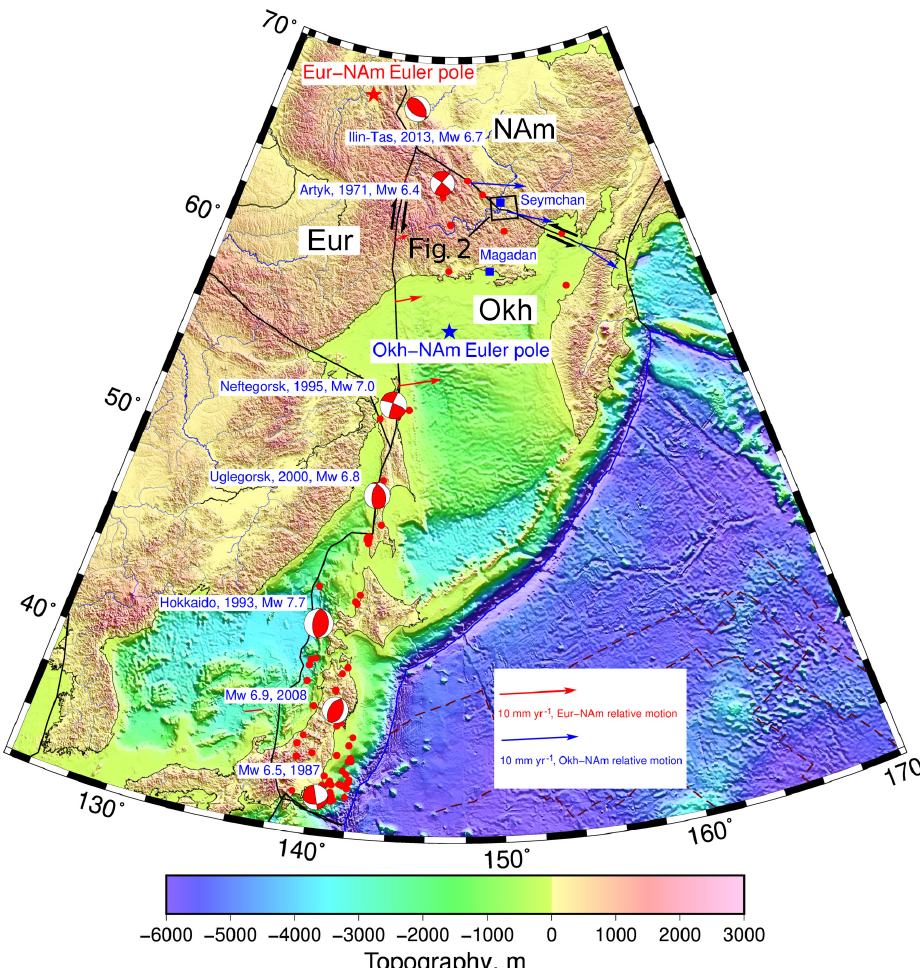
Figure 1. Tectonics of the Okhotsk plate and surroundings. Earthquakes > M w 5 . 0 are shown by red dots. Earthquakes > M w 6 . 0 are shown with focal mechanisms. Locations of Eur–NAm and Okh–NAm poles used to calculate relative motion vectors (blue arrows: Okh–NAm; red arrows: Eur–NAm) shown by blue and red stars. The black box shows the location of Fig. 2 and of the study area, and the town of Seymchan. The region is principally considered a part of the Eurasia–North American plate boundary zone, and as such has increasingly been recognised to consist of a number of smaller plates or micro-plates, which can be proven to provide statistically better fits to global plate-tectonic data. Nevertheless, there is a considerable amount of intraplate seismicity in the region, especially northwestern